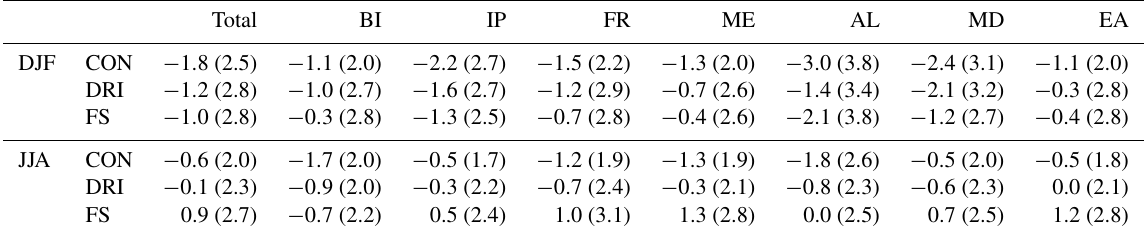
Table 2. The daily mean 2m temperature bias ( ◦ C) and root mean square error (RMSE) (in brackets) between the downscaled simulations and E-OBS for the total domain and the subdomains (BI, IP, FR, ME, AL, MD, EA) during DJF and JJA for the 10-year period from 1991 to